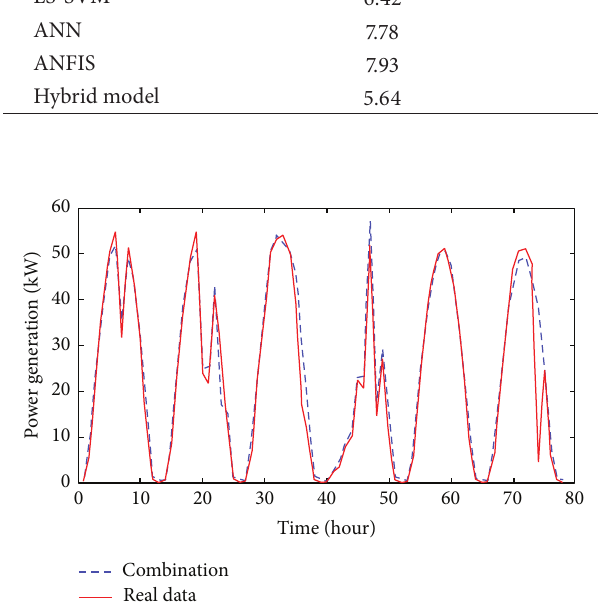
Figure 11: Forecasting results for PV power at Taichung Thermal Power Plant by using the hybrid combination